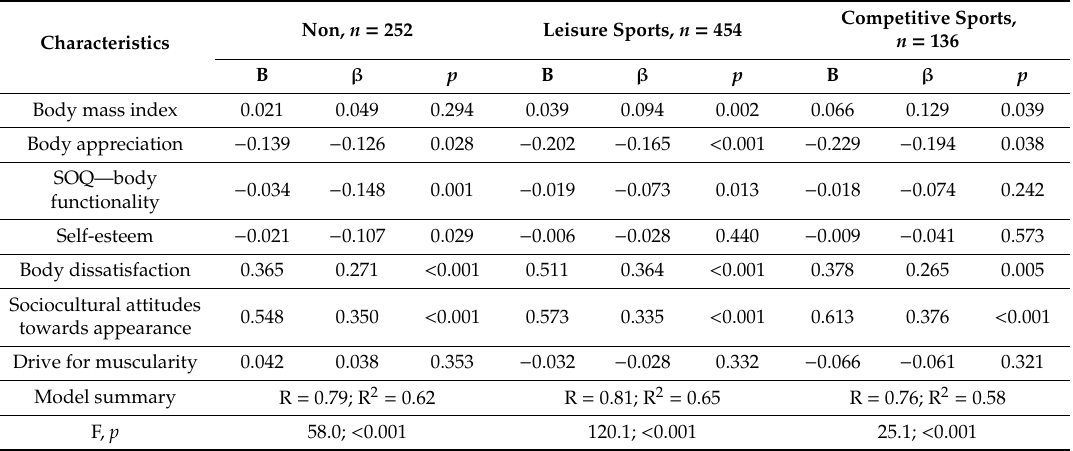
Table 6. Factors associated with higher risk of disordered eating in sports groups in a sample of girls ( n =